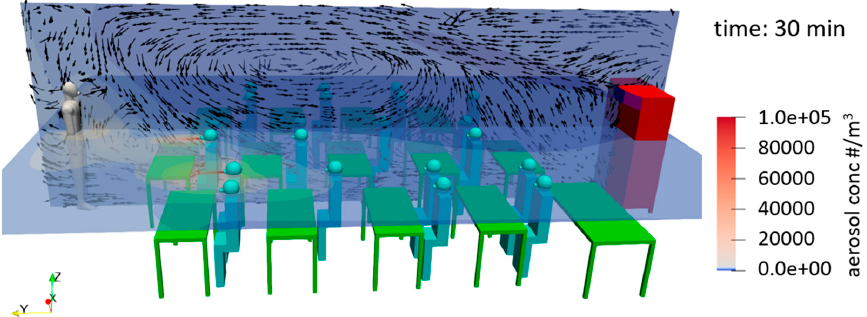
Figure 11. The aerosol concentration after 30 min with AP 1. The colors denote the aerosol concen- tration, whereas the arrows show the local air velocity. tion, whereas the arrows show the local air